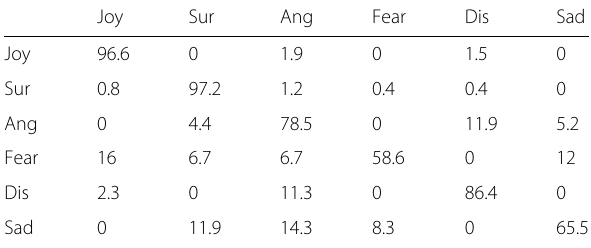
Table 5 Confusion matrix (%) of leave-one-out testing method for 6-class emotion in CK+ dataset using Improved GLTP Joy